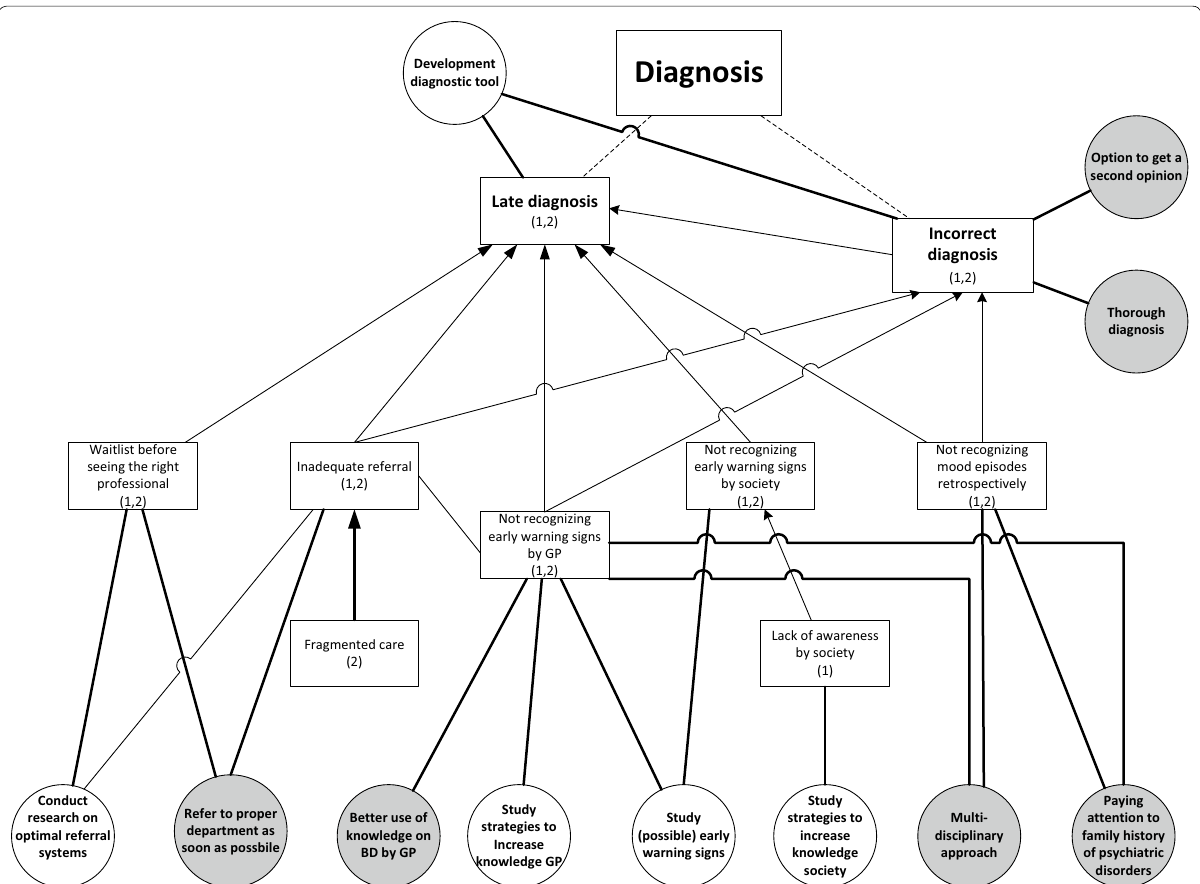
Fig. 1 Challenges with diagnosis (squares) including relating research needs (white circles) and care needs (grey circles). (1): mentioned in study on research needs; (2): mentioned in study on care needs. Dotted lines: division of challenges into sub challenges. Arrows: causal relation